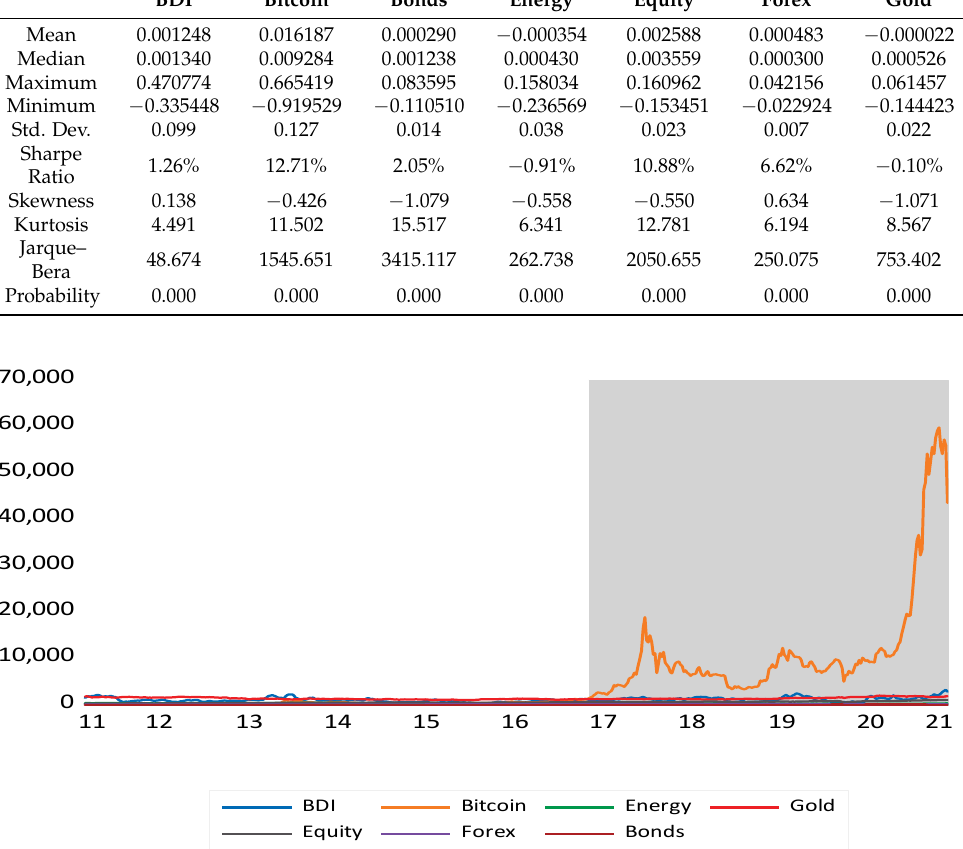
Figure 1. Price development of all assets.